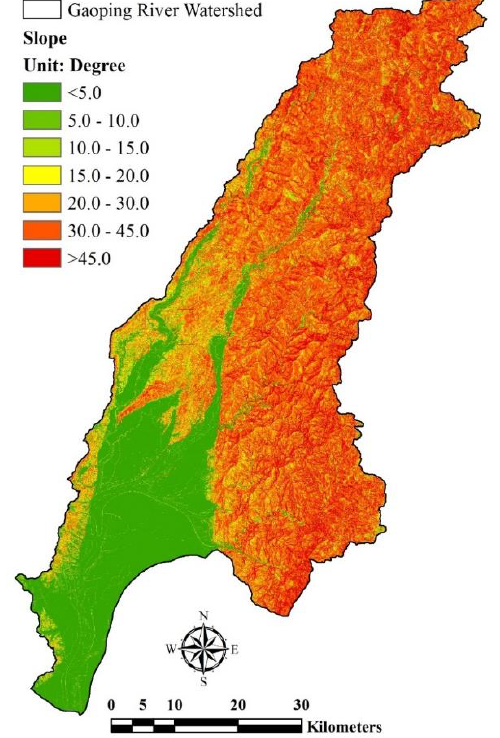
Figure 8. Slope map of Gaoping River watershed.